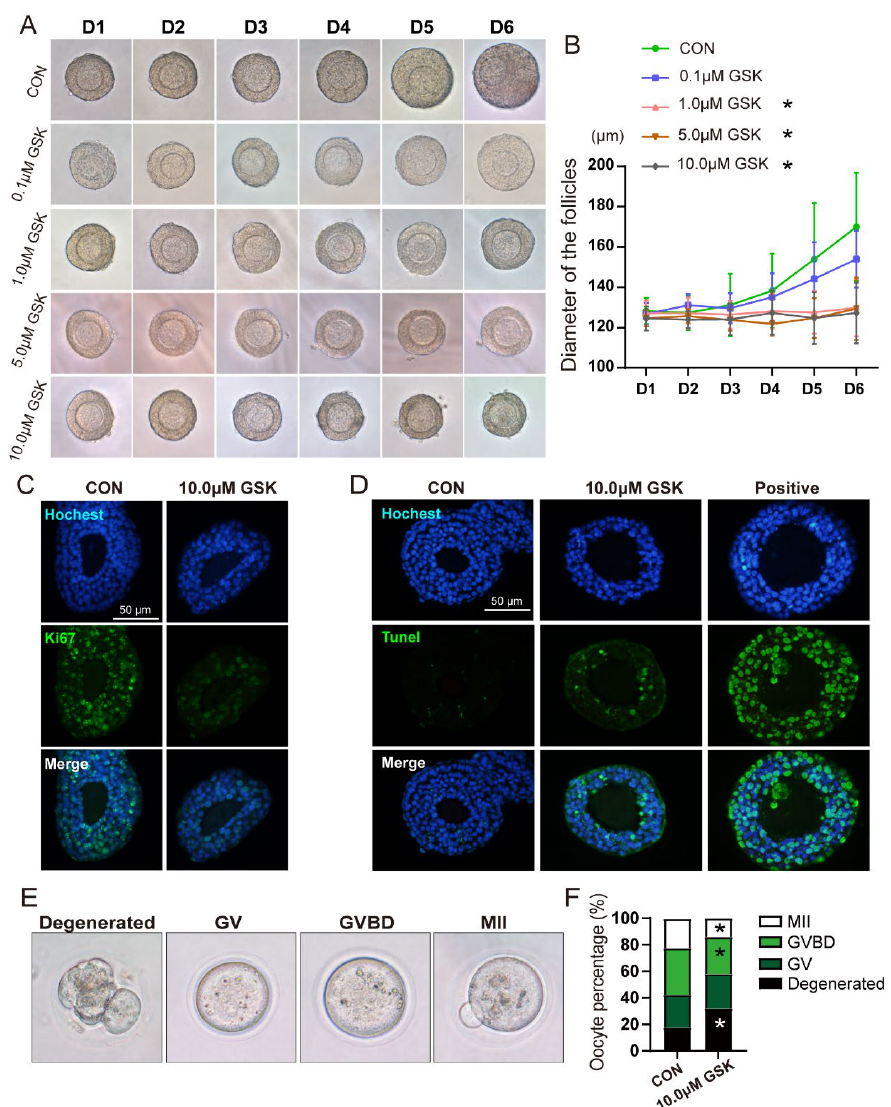
Figure 5. Effect of WIP1 inhibitor on secondary follicle development in vitro. ( A ) Morphological analysis of follicle growth. ( B ) Diameters of follicles treated with different concentrations of GSK2830371 ( n ≥ 10, one-way ANOVA). ( C ) Ki67 staining of follicles cultured with GSK2830371 treatment. ( D ) Representative images of TUNEL staining of cultured follicles. ( E ) Microphotographs showing